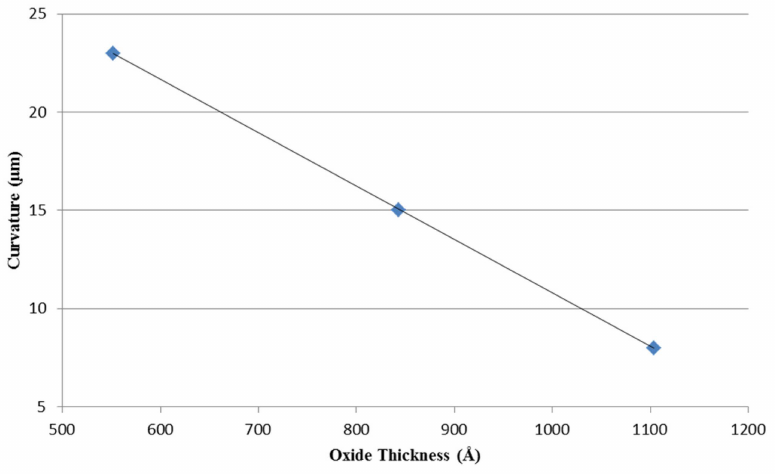
Figure 5. Plot of cantilever curvatures versus oxide thickness. Beam curvature decrease linearly with increasing oxide thickness grown prior to cantilever sensor